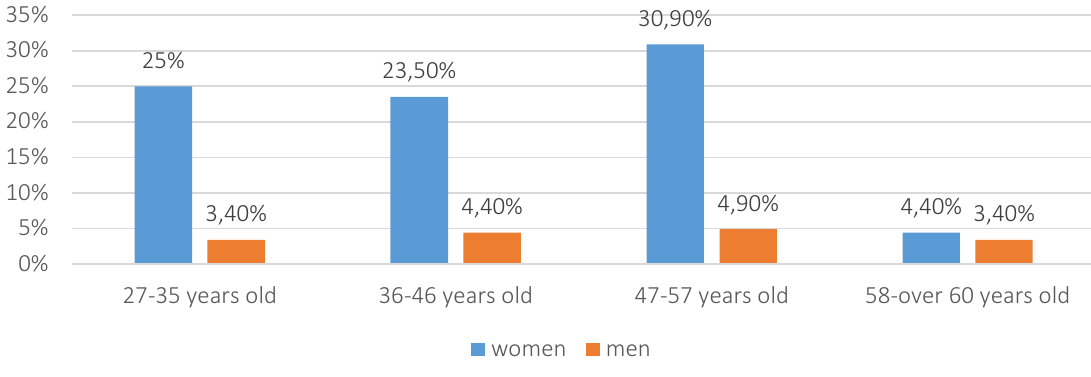
Figure 4. Medical staff by age